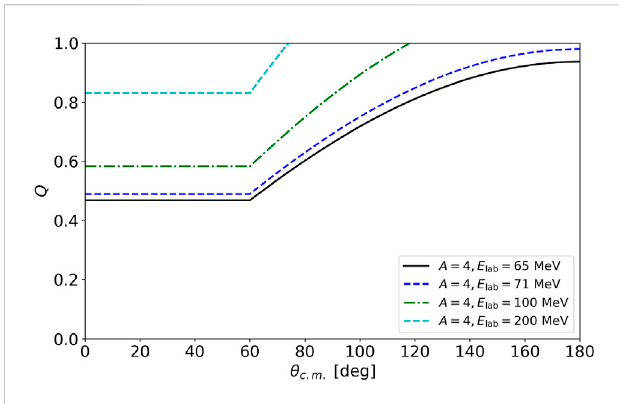
FIGURE 2 The expansion parameter Q , de fi ned by Eq. 30 where Λ b = x600 MeV, as a function of the center-of-mass angle θ c.m. for a range of lab projectile energies E lab . In this case of nucleon-nucleus (NA) elastic scattering,thetransitionbetweenwhentheexpansionparameteris dominated by the center-of-mass momentum and the momentum transfer can easily be identi fi